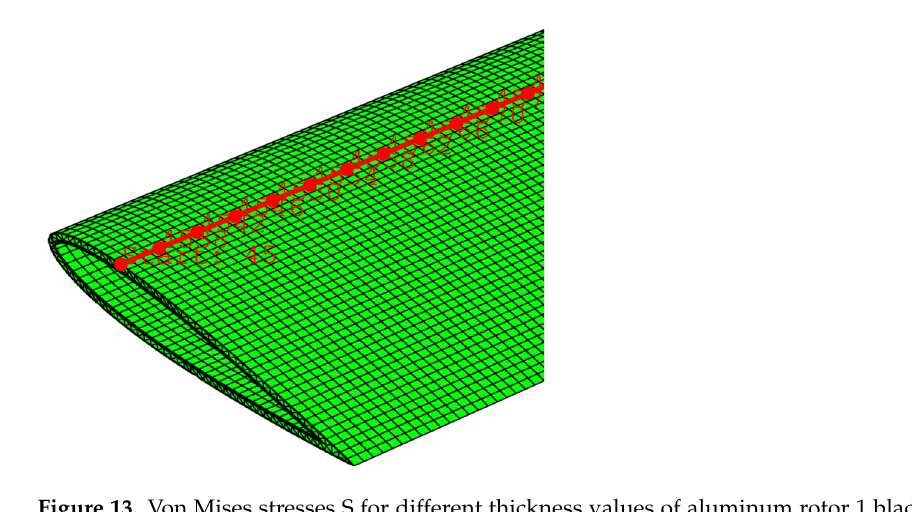
Figure 13. Von Mises stresses S for different thickness values of aluminum rotor 1 blade after the application of extreme loads.